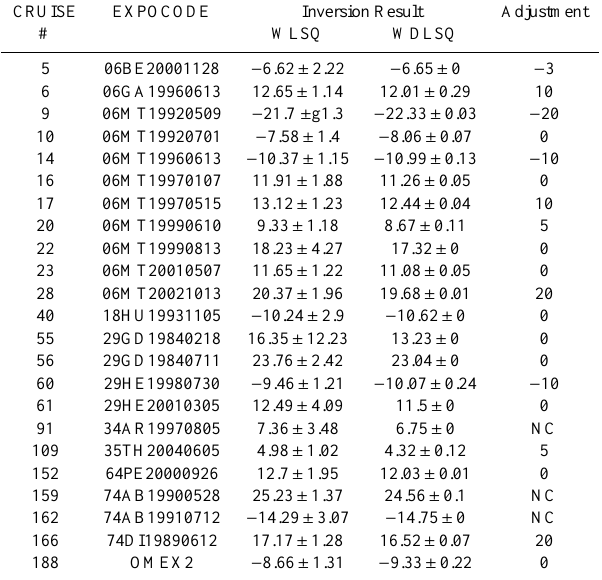
Table 4. Salinity corrections suggested by the WLSQ (Weighted Least Square) and WDLSQ (Weighted Damped Least Square) in- versions used for the salinity adjustments for the Atlantic Ocean part of CARINA, and the adjustments that were actually applied to the data. Note that salinity is expressed in a thousands of a salinity (i.e. ppm). Only cruises for which the inversions suggest a signifi- cant (i.e. > 5ppm) correction are listed. NC stands for “Not Consid- ered” and no adjustment is applied, as described in the text.